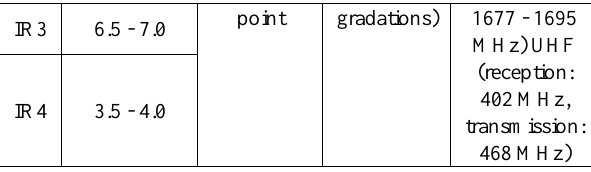
Table 1. Technical specification of payloads of